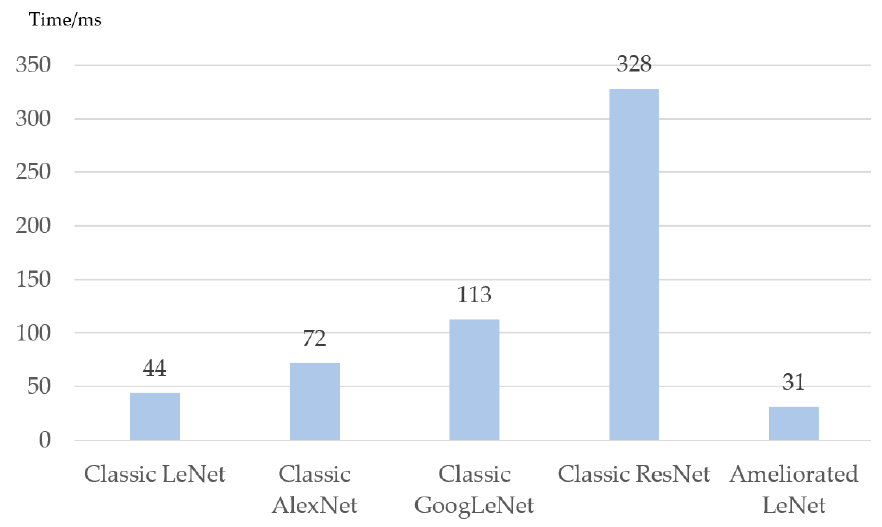
Figure 19. The time spent training each sample for the different networks studied.